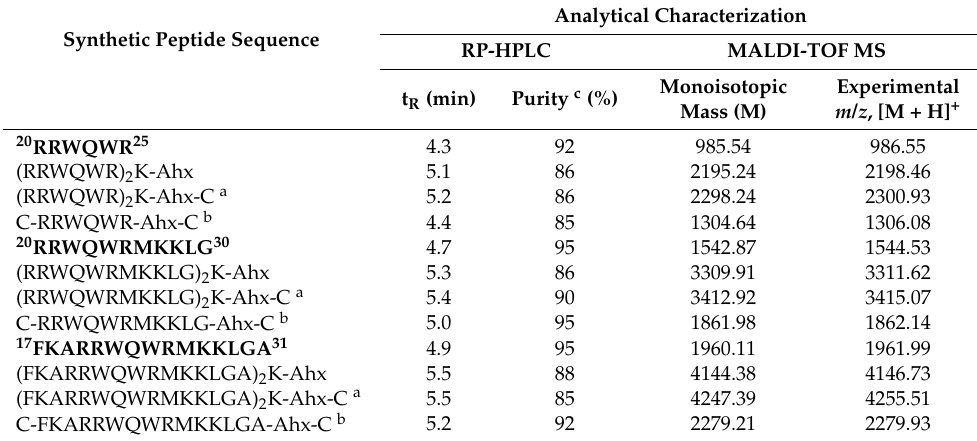
Table 1. Analytical characterization summary of designed and synthesized LfcinB-derived peptides.